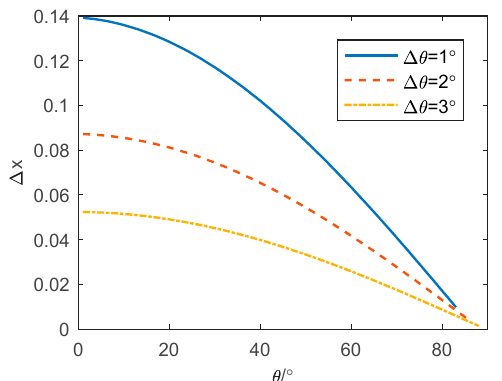
Figure 4. The value profile of ∆ x with different ∆ θ .